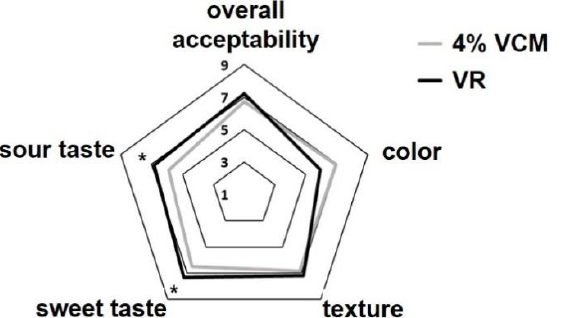
Figure 6. Analysis of sensory evaluation characteristics of apples by anti-browning reagents. Sensory analysis results for apple treated with 4% VCM and VR. Statistical significance compared with the 4% VCM and VR group was determined by the Student’s t -test (* p < 0.05).